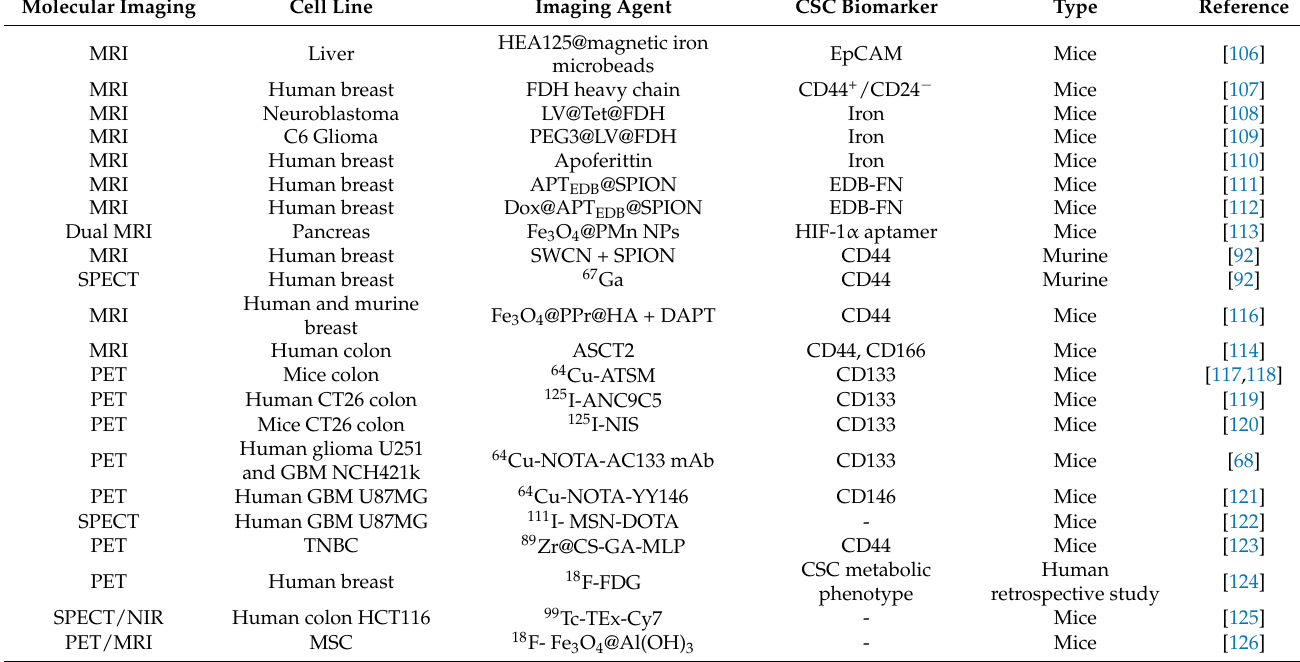
Table 3. Molecular imaging methods developed for cancer stem cell imaging in